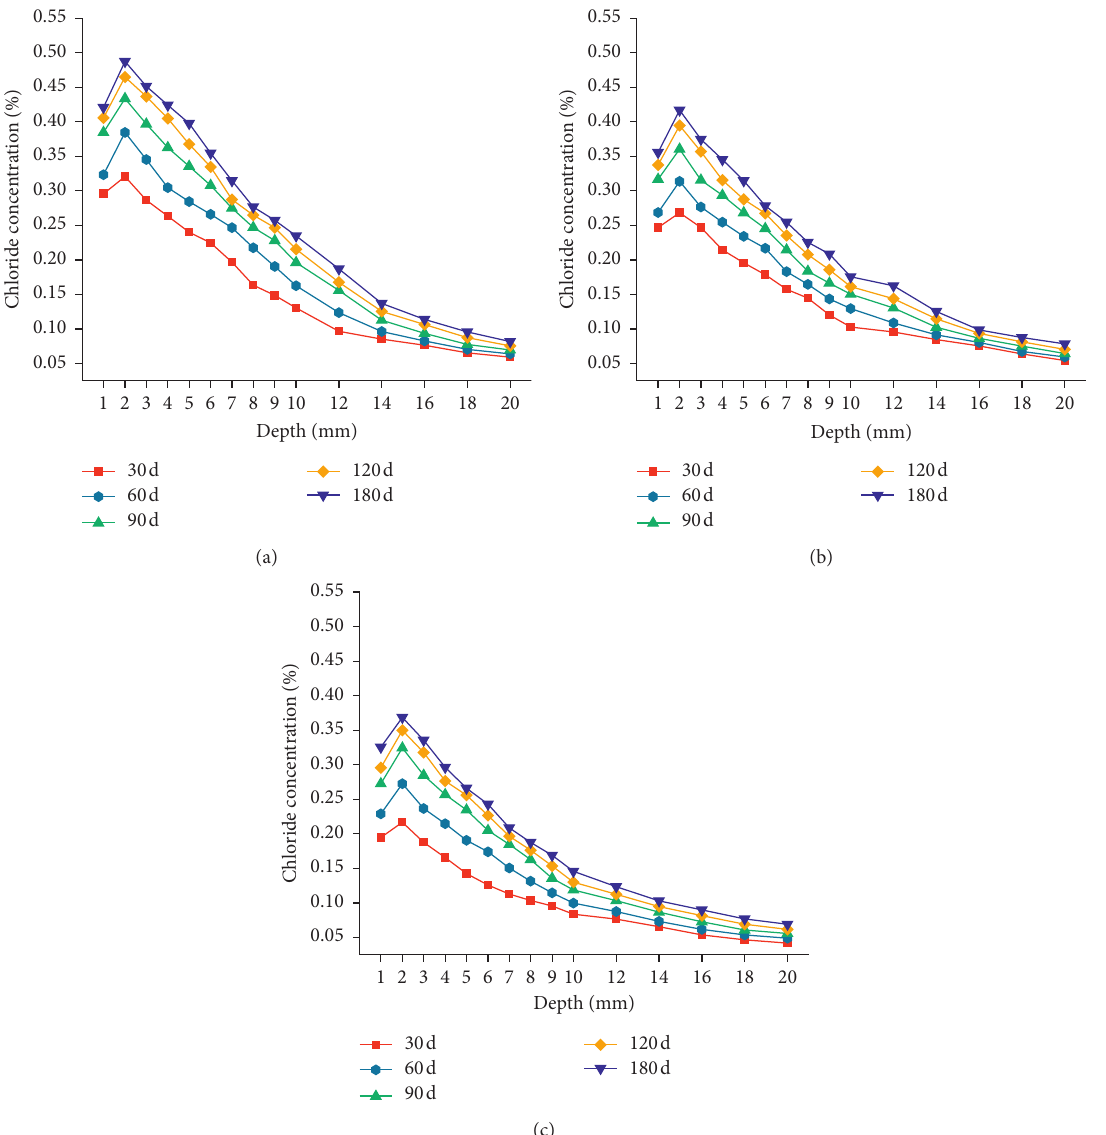
Figure 6: Chloride concentration distribution of BPFRC with different strength grades. (a) BPC-30-0.1. (b) BC-40-0.1. (c)